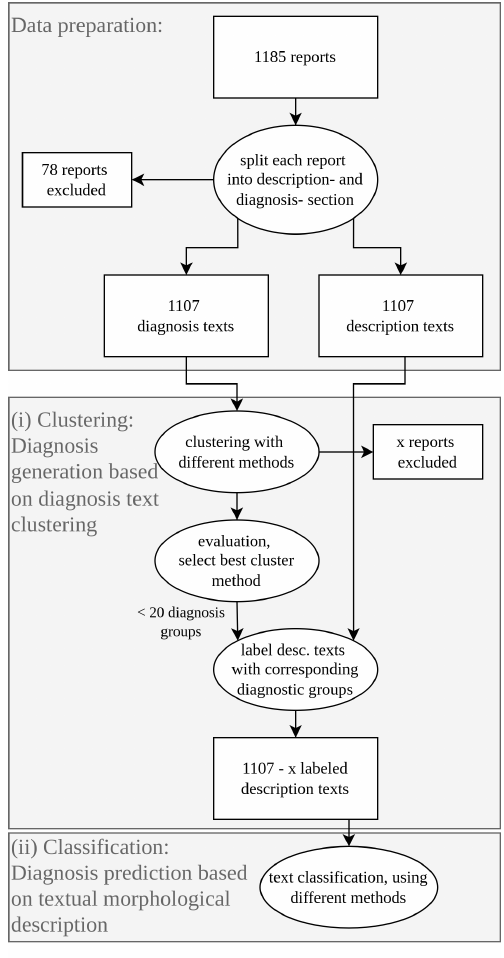
Figure 1. Flowchart, describing the general procedure of the project. After splitting each nephropatho- logical report into its diagnosis and description section (data preparation), we first applied the cluster- ing task (i) to the diagnosis texts in order to summarize them into less than 20 clusters. After labelling each cluster of diagnosis texts with a corresponding diagnostic group, we applied the classification task (ii) to the description texts in order to find out if it’s possible to predict the correct diagnostic group of a given description text with NLP